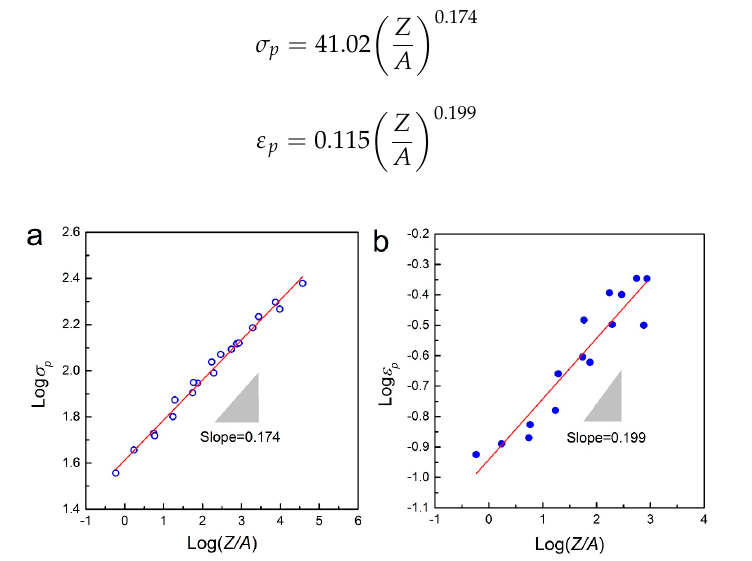
Figure 7. Correlations between ( a ) log σ p vs. log( Z / A ) and ( b ) log ε p vs. log( Z / A ).